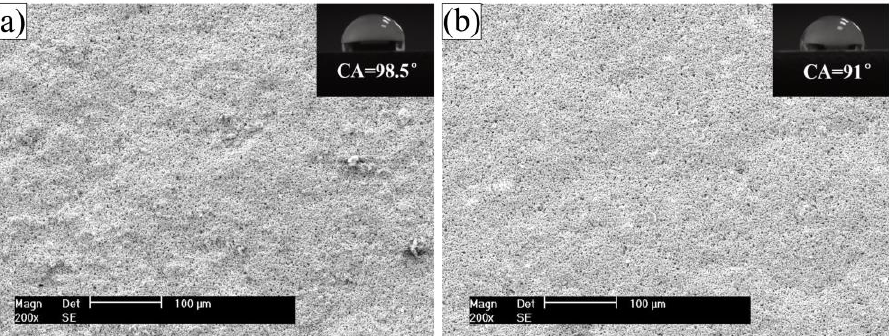
Figure 1. SEM images of the surface morphologies of coatings, ( a ): CGC and ( b ): CPTES/CGC. Inserts are the images of the water droplets on the corresponding coatings.